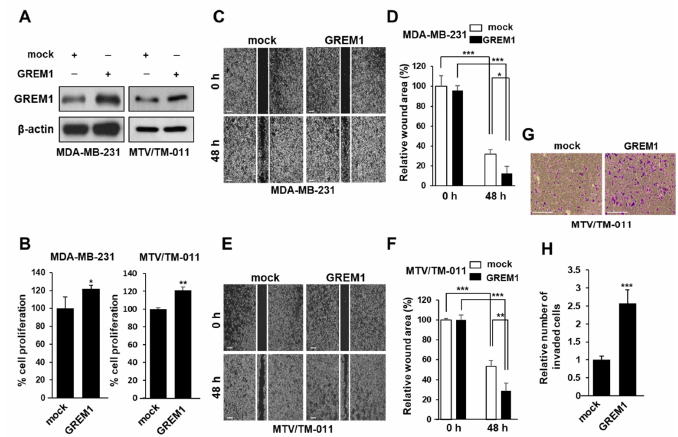
Figure 3. GREM1 overexpression enhances the growth and mobility of breast cancer cells. ( A ) MDA- MB-231 and MTV/TM-011 cells were transfected with each indicated plasmid for 48 h, and the expression level of GREM1 was evaluated by Western blot analysis. ( B ) The effect of ectopic overexpression of GREM1 on cell proliferation was examined. Two-sided t -test. ( C – F ) Cells were